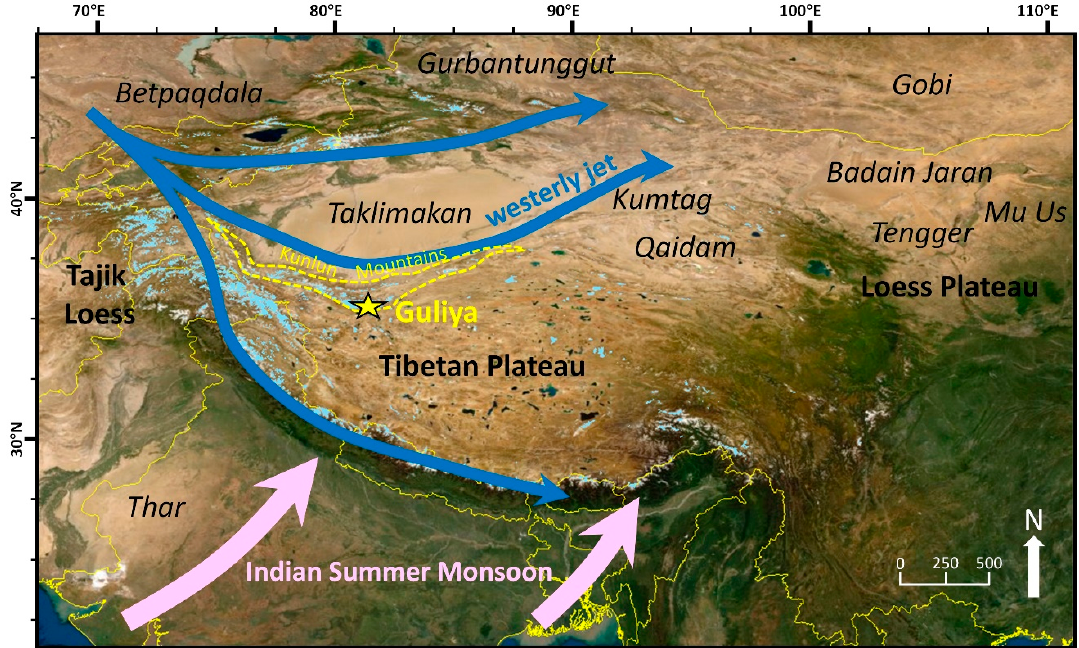
Figure 1. Third Pole region with the location of the Guliya ice cap (yellow star) in the Kunlun Mountains (yellow dashed line), the main deserts and loess sub-regions. The arrows depict the trajectories of the main seasonal air masses that influence NW Tibet climate. (Source background image: ESRI, world imagery.).